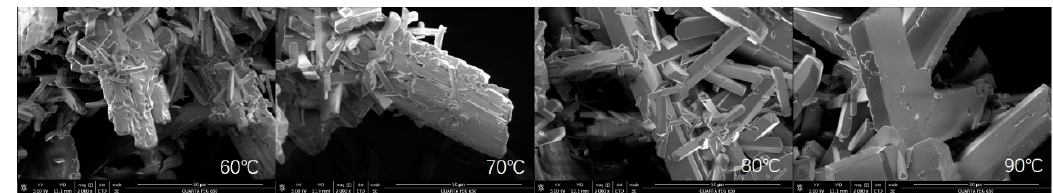
Figure 8. Effect of temperature on thermal decomposition crystallization [agitation speed = 300 rpm].